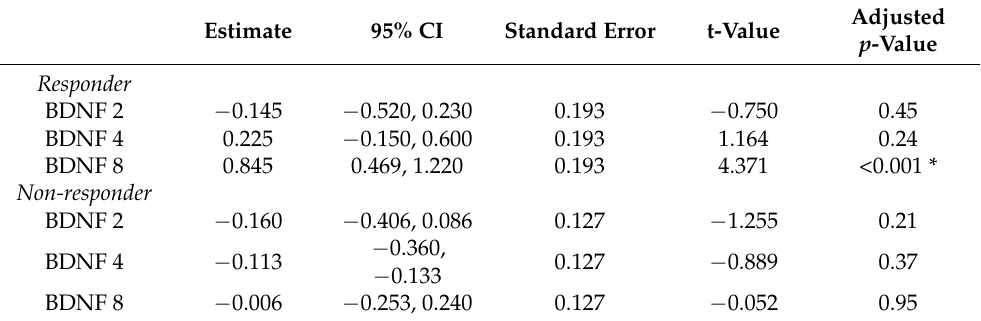
Table 4. Changes in serum BDNF (Change from BDNF 0).